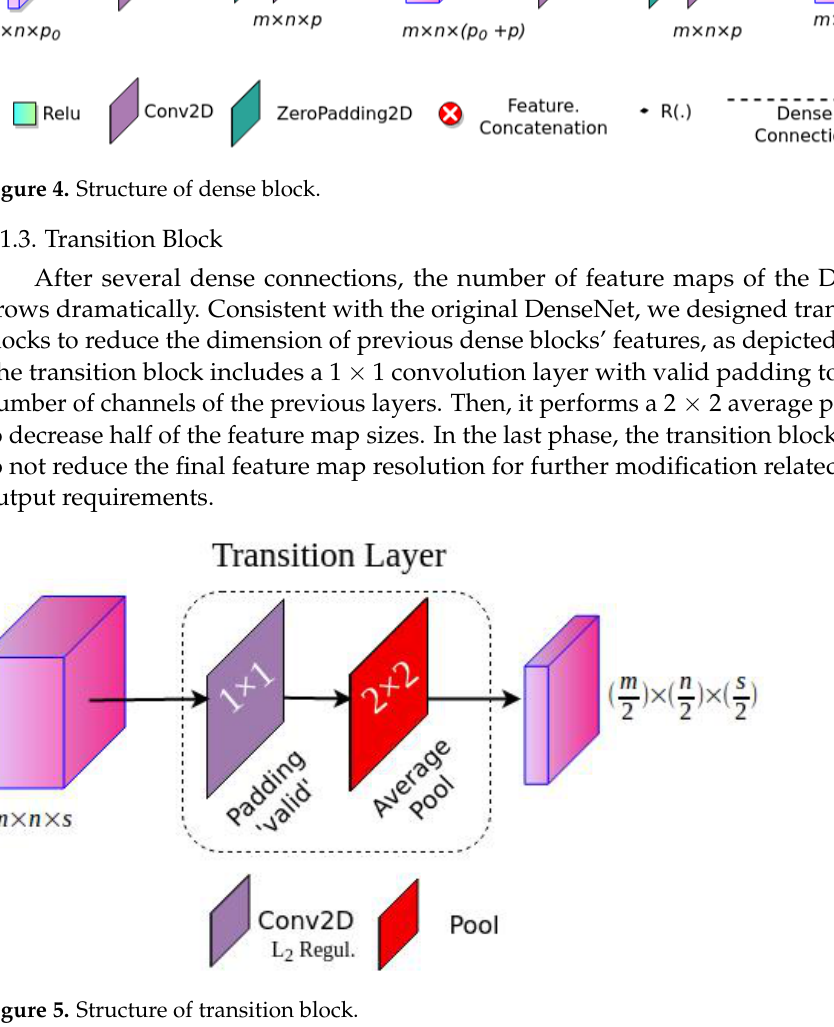
Figure 5. Structure of transition